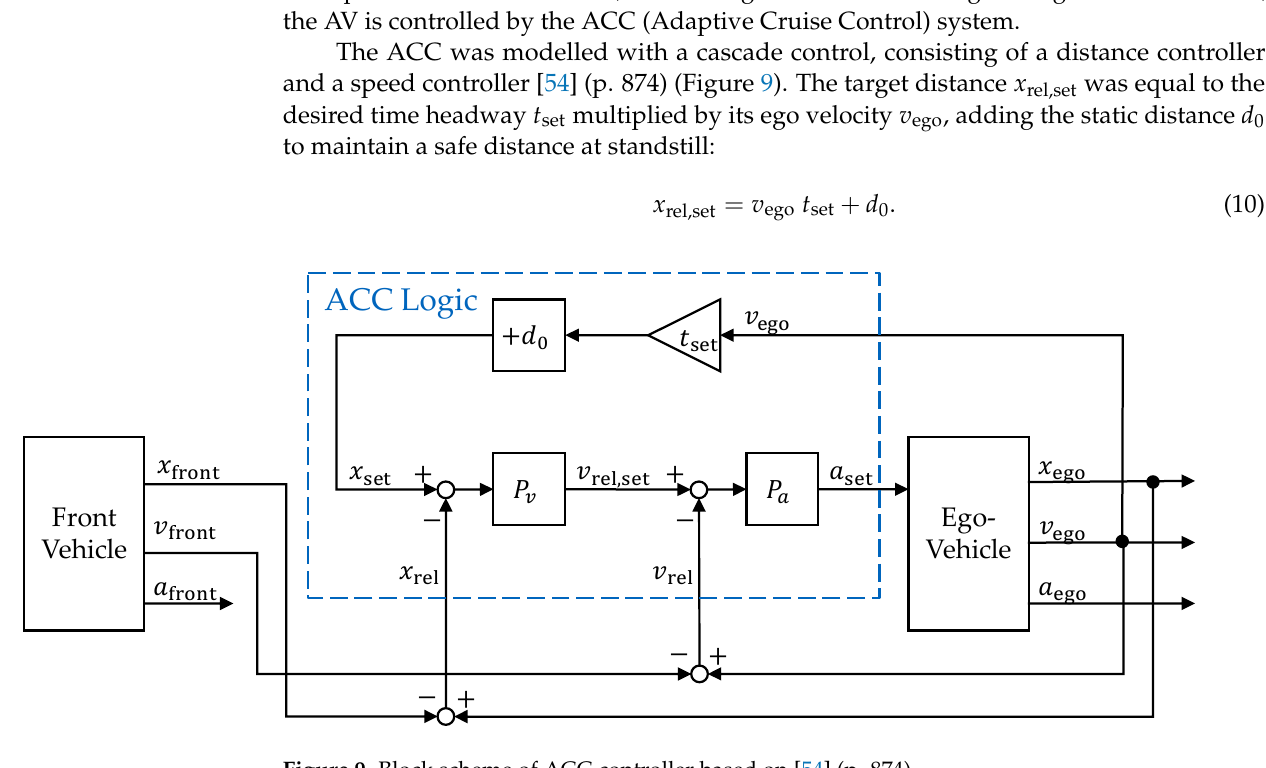
Figure 9. Block scheme of ACC controller based on [54] (p. 874).